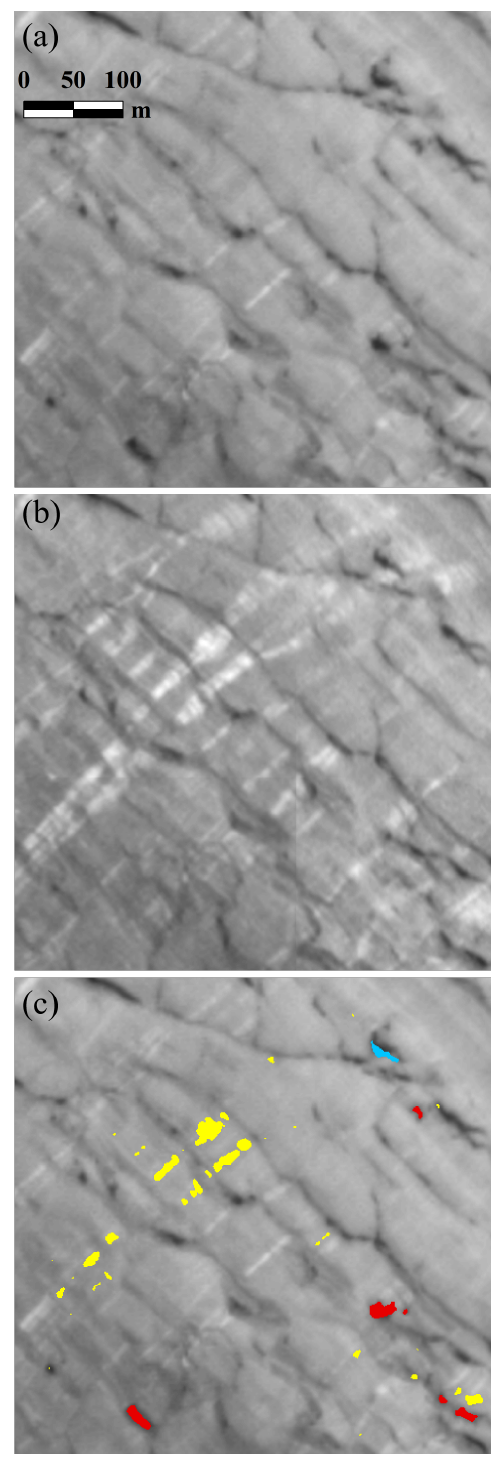
Figure 3. Detailed views of change detection process. (a) portion of the “Before” image, (b) portion of the “After” image, (c) change detection: in yellow are the detections that are automatically eliminated as false detections due to seasonal CO 2 ice; in blue are the detections that are automatically eliminated as false detections caused by shadow deformation; in red are the final detections of the